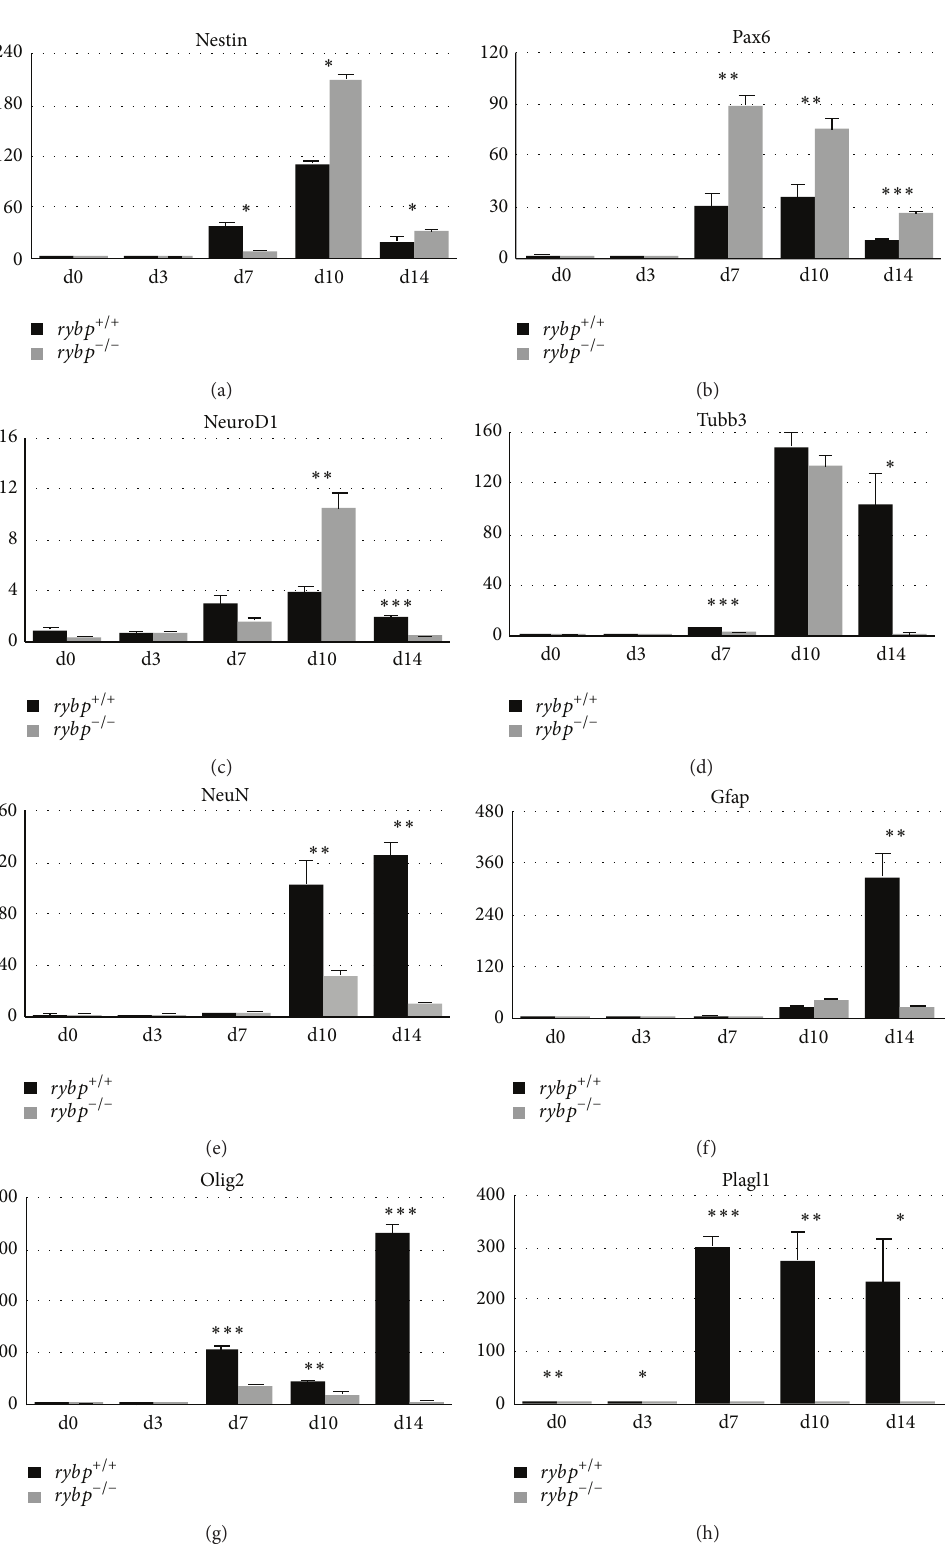
Figure 3: Neural markers (Nestin (a), Pax6 (b), NeuroD1 (c), Tubb3 (d), NeuN (e), Gfap (f), and Olig2 (g)) and transcription factor, Plagl1 (h), exhibit altered expression in the lack of Rybp during in vitro neural differentiation. Relative gene expression of key neural markers was analyzed with qRT-PCR. For the analysis RNA was extracted and reverse-transcribed from differentiated neural cell culture generated from 𝑟𝑦𝑏𝑝 +/+ and 𝑟𝑦𝑏𝑝 −/− ESCs. Samples are collected at days 0, 3, 7, 10, and 14 of differentiation. The expressions of the indicated markers were normalized to Hprt expression, which was used as an internal control. Means are standard deviation. Values of 𝑃 < 0.05 were accepted as significant ( ∗ 𝑃 < 0.05 ; ∗∗ 𝑃 < 0.01 ; ∗∗∗ 𝑃 < 0.001 ). Statistical method: 𝑡 test type